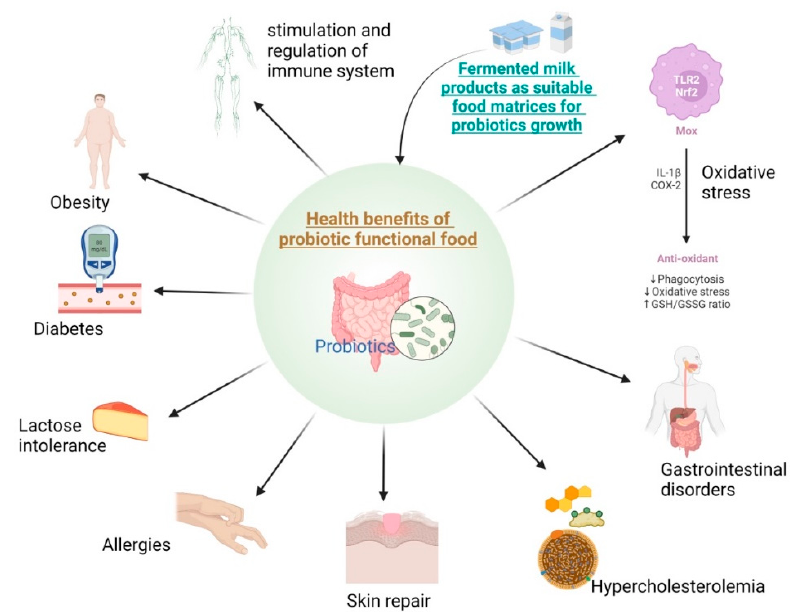
Figure 1. Fermented dairy-based product health benefits.